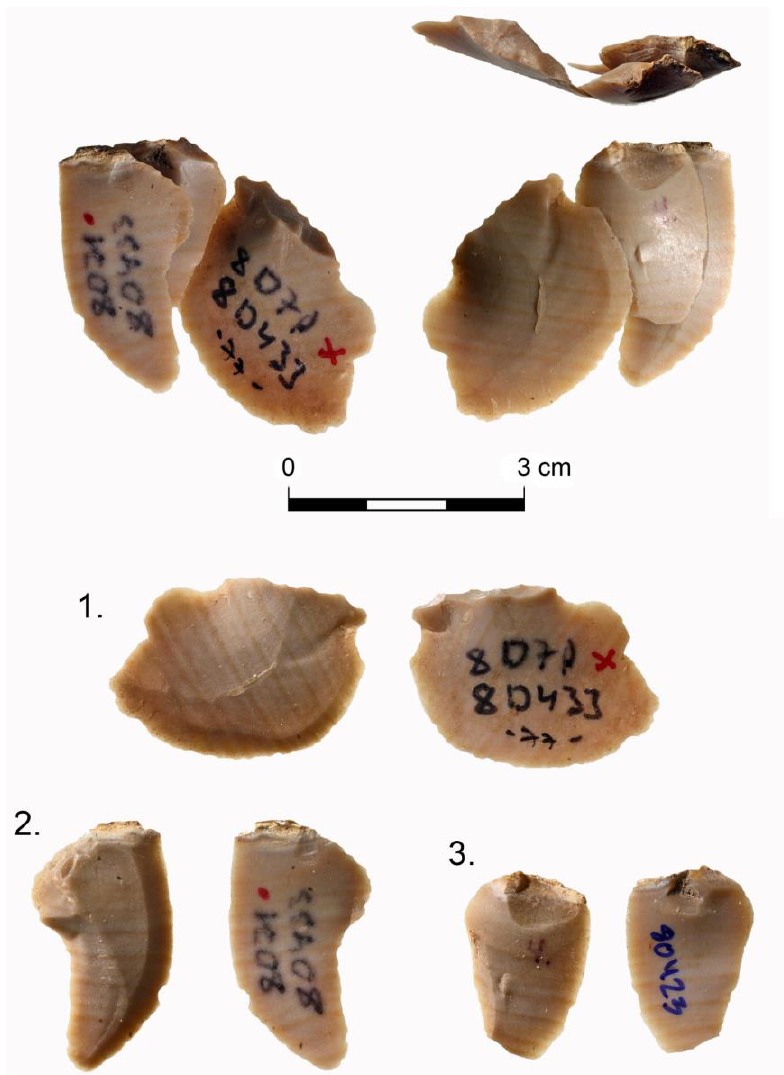
Figure 11. The refitting sequence of blanks produced from